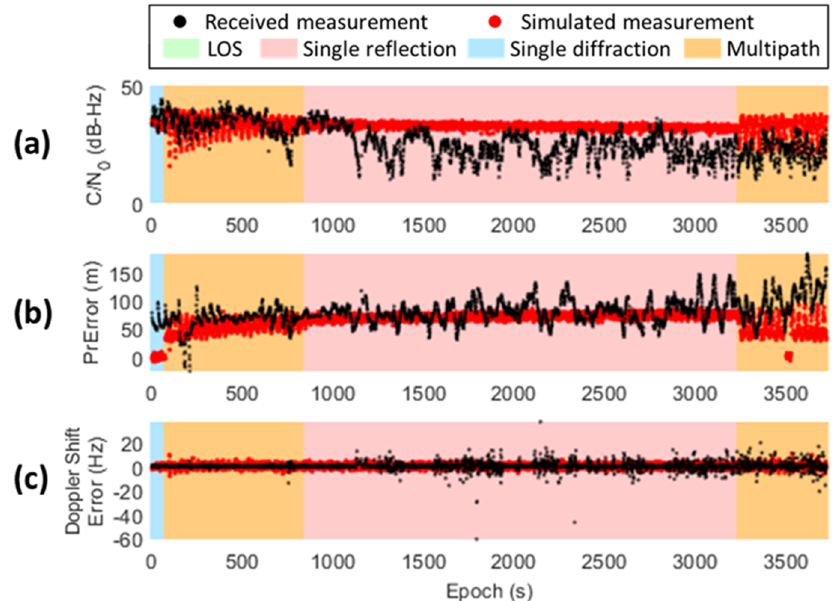
Figure 13. The comparison of the simulated and actual received GNSS measurements from G29 satellite during the long-period static experiment, including: ( a ) C / N 0 ; ( b ) pseudorange error; ( c ) Doppler shift error. The colored background denotes the measurement status being categorized during the simulation, including: LOS, single reflection, single diffraction, and multipath.